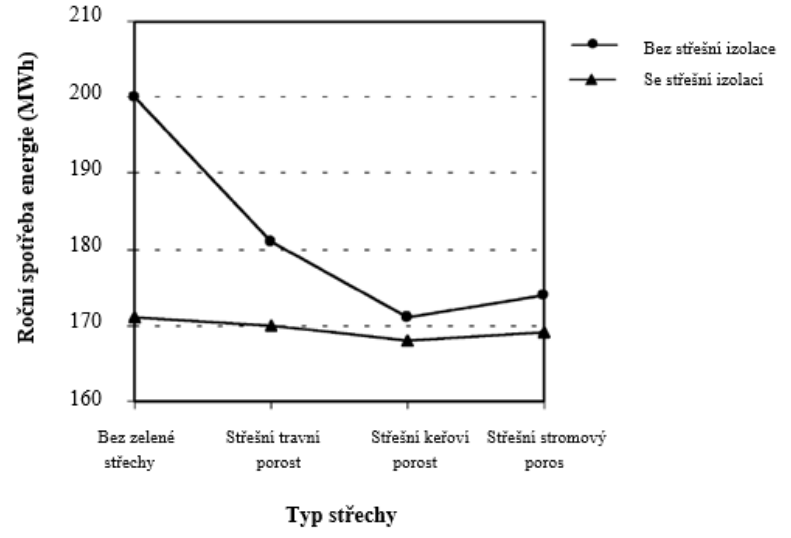
Graf 1: Srovnání roční spotřeby energie dle typu střechy komerční budovy, Wong a kol. [16] Z grafu je viditelné, že neizolované střešní konstrukce v případě použití travního porostu